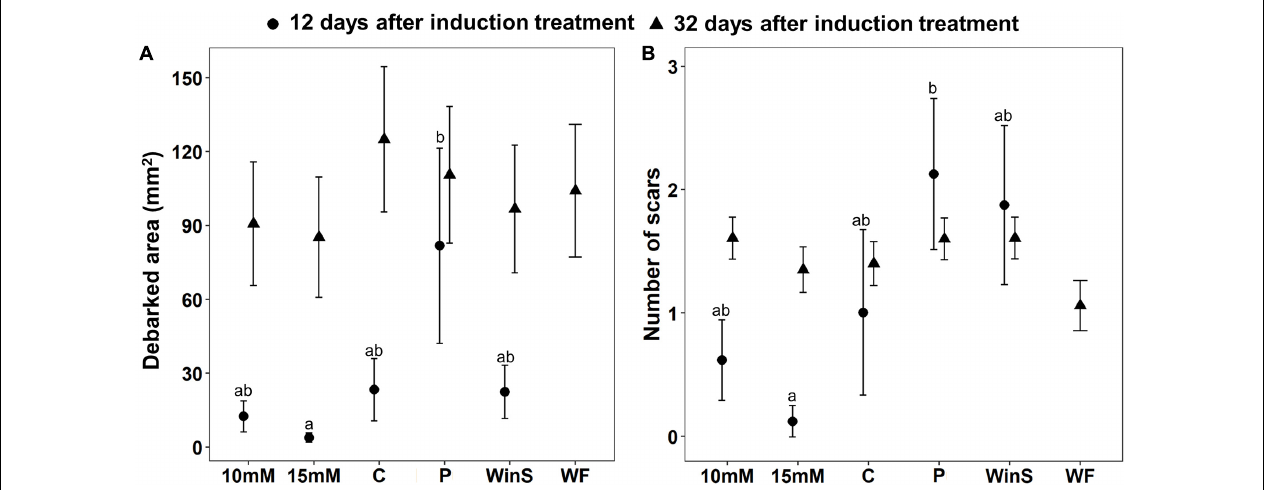
FIGURE 3 | Pine weevil damage to Scots pine ( P. sylvestris ) seedlings after receiving different induction treatments [10 mM MeJA, 15 mM MeJA, undamaged seedlings as controls (C), needle-piercing damage to the stem bark (P), small stem window damage (WinS), and previous weevil feeding damage (WF, not included in the weevil exposure test conducted 12 days post-treatment)] in experiment 2. Plants that were exposed to pine weevils 12 days after induction treatments are referred to as early exposure, and those that were exposed 32 days after, are referred to as late exposure in the main text. (A) Estimated mean debarked area (mm 2 ± standard error), and (B) Estimated mean number of feeding scars ( ± standard error). Sample size ( n ) is equal to 8 for all other treatments, except that the Control group (C) is equal to 7 for the early exposure, and n = 12 for all treatments for the late exposure. Different letters above means indicate statistically significant differences ( P < 0.05) between mean